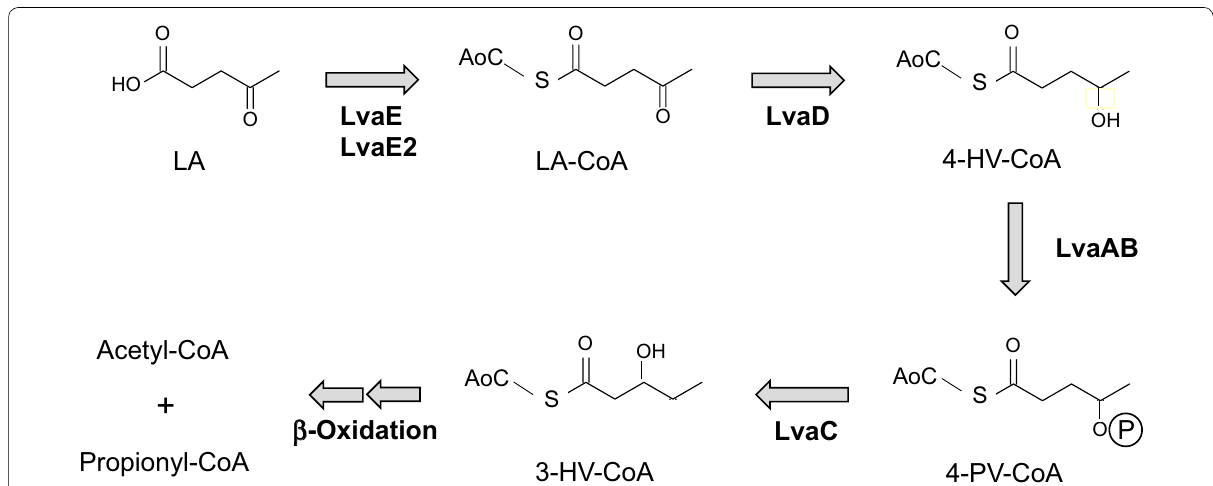
Fig. 1 Proposed pathway and enzymes for the conversion of levulinic acid to 3-hydroxyvalelyl-CoA by Pseudomonas spp. LA levulinic acid, LA-CoA levulinyl-CoA, 4HV-CoA 4-hydroxyvaleryl-CoA, 4-PV-CoA 4-phosphovaleryl-CoA, 3-HV-CoA 3-hydroxyvaleryl-CoA. The proposed pathway is quoted from Rand et al. (2017) with some